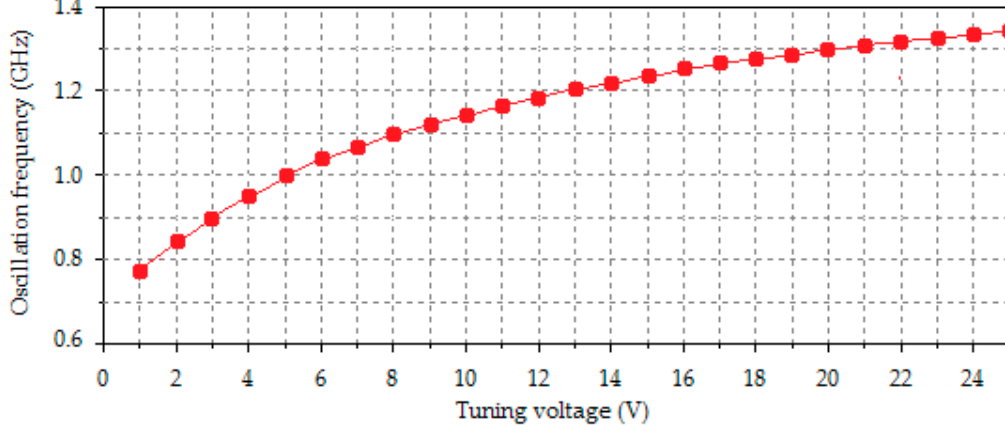
Figure 14. VCO tuning characteristic.